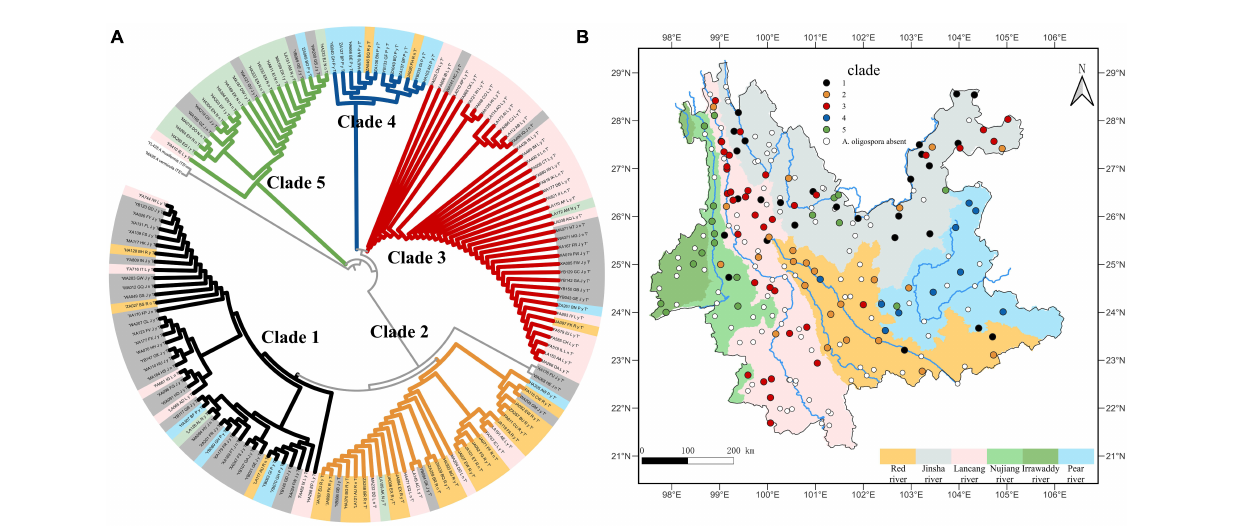
FIGURE6 (A) Shows the phylogenetic tree of A. oligospora , with the color of the label of each node representing the watershed to which it belongs, consistent with the color of the watershed in (B) . (B) Shows the clades biogeographical distribution of A. oligospora when the watershed is used as the unit of study.